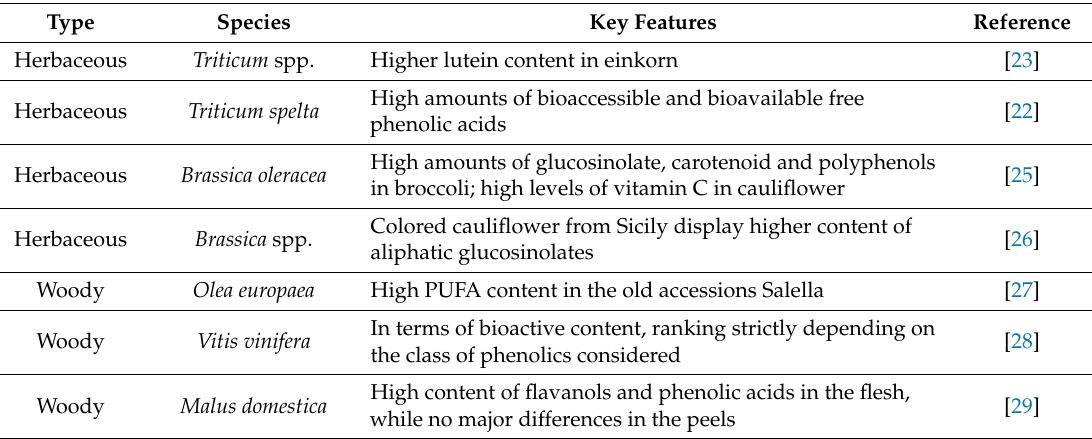
Table 1. Summary of some studies addressing the quantification of bioactives in ancient local varieties of herbaceous and woody